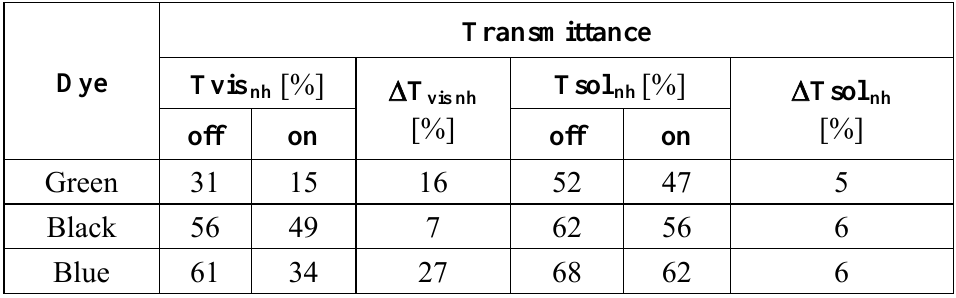
Table 3. Degree of visible and solar transmittance of thermochromic PE